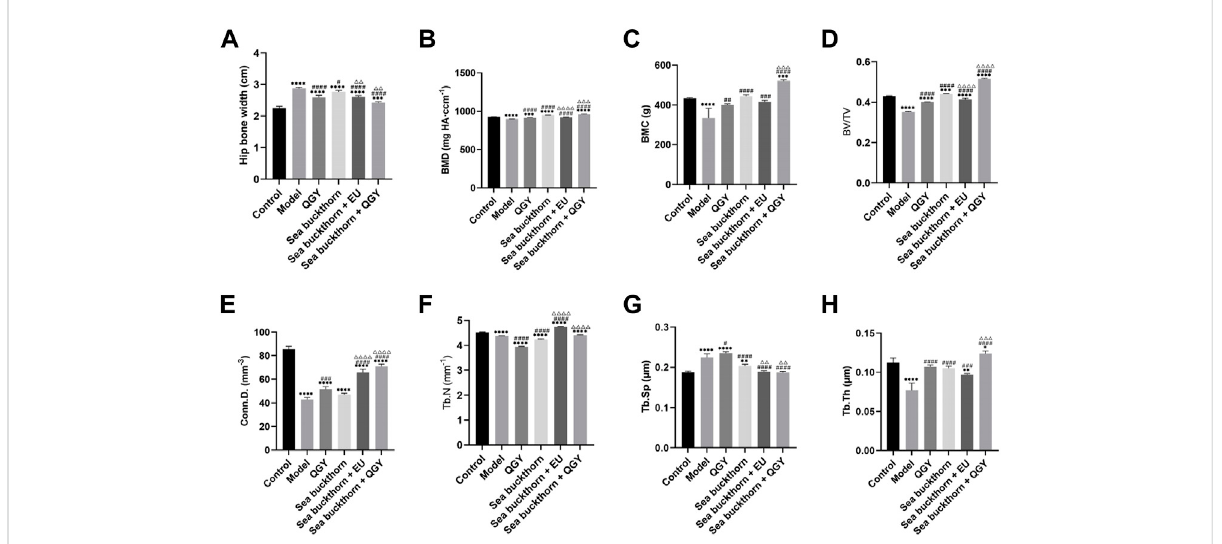
FIGURE 2 Analytical results ofmicro-CT for bonemorphometry. (A – H) Results ofthehipbone width, BMD, BMC, BV/TV, Conn.D.Tb.N,Tb.Sp, and Tb.Th. *, **, ***, and **** show p < 0.05, p < 0.01, p < 0.001, and p < 0.0001, respectively, in comparison with the normal control group; #, ##, ###, and #### show p < 0.05, p < 0.01, p < 0.001, and p < 0.0001, respectively, in comparison with the PMOP model group; △ , △△ , △△△ , and △△△△ show p < 0.05, p < 0.01, p < 0.001, and p < 0.0001, respectively, in comparison with the QGY